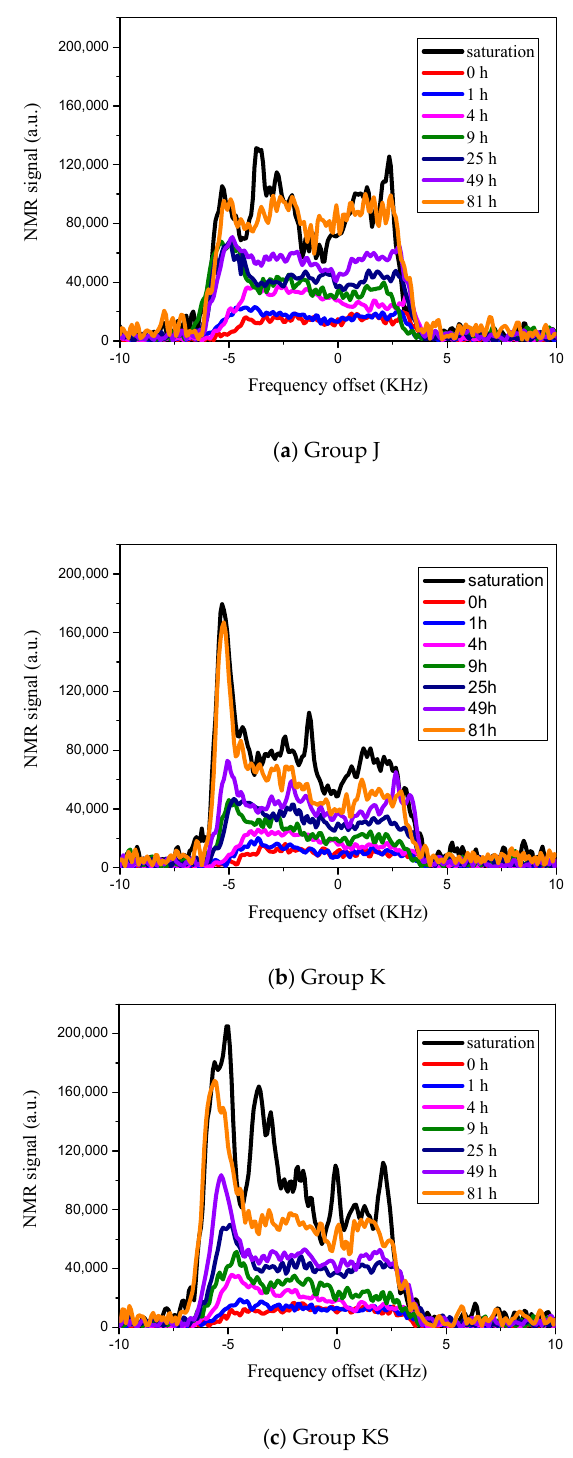
Figure 4. Signal values of the water absorption process obtained by the NMR test .